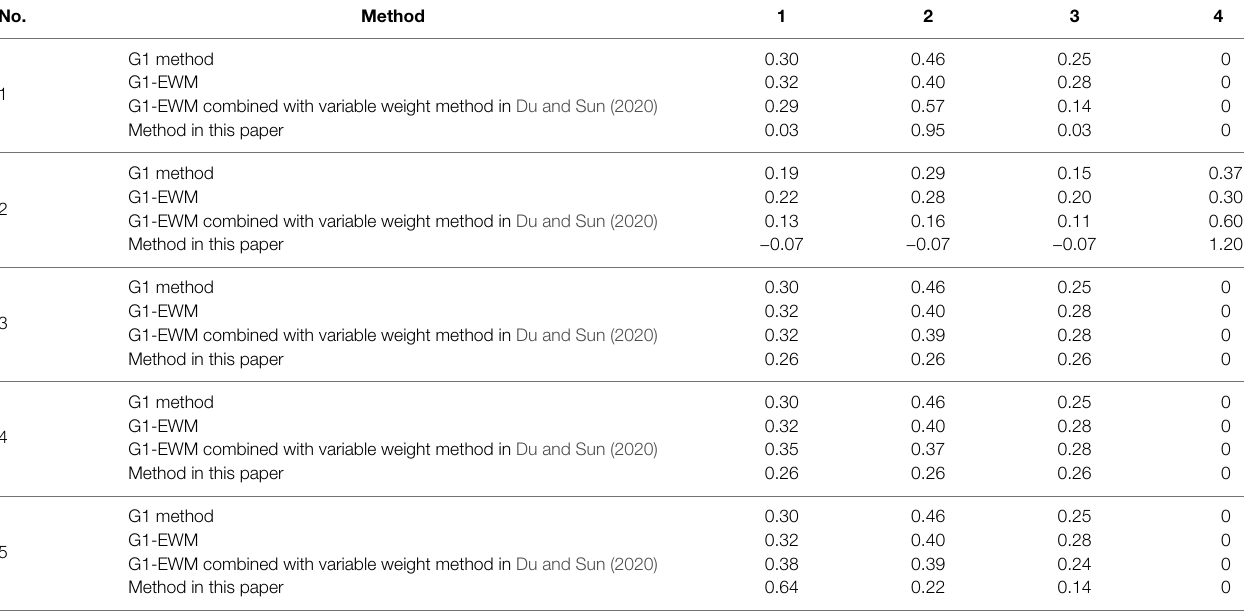
TABLE 9 | Comparison of weighting results.